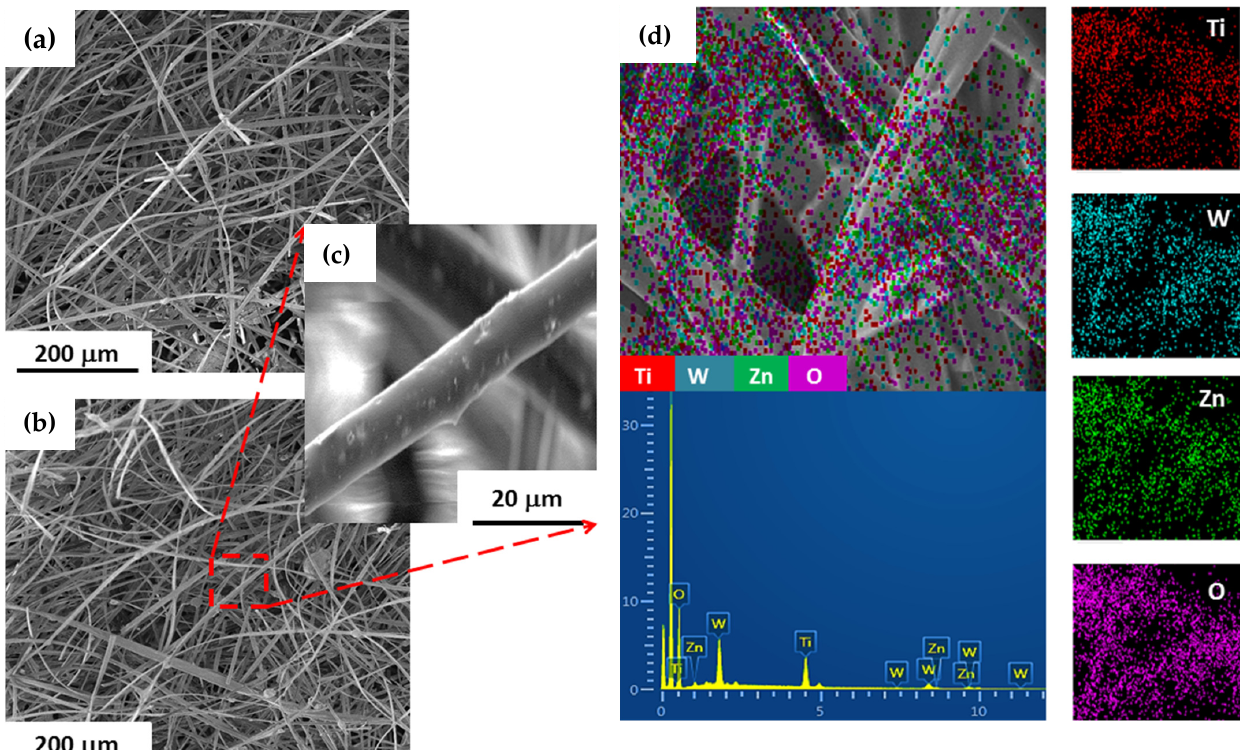
Figure 2. Scanning electron microscopy (SEM) images of TW − Zn MOHN -loaded electrospun fibers with ( a ) 2 wt% and ( b ) 4 wt% of zinc oxide (ZnO); ( c ) representative SEM micrograph of the fiber surface and ( d ) energy dispersive spectroscopy (EDS) elemental composition and mapping of TW − Zn 2 samples.